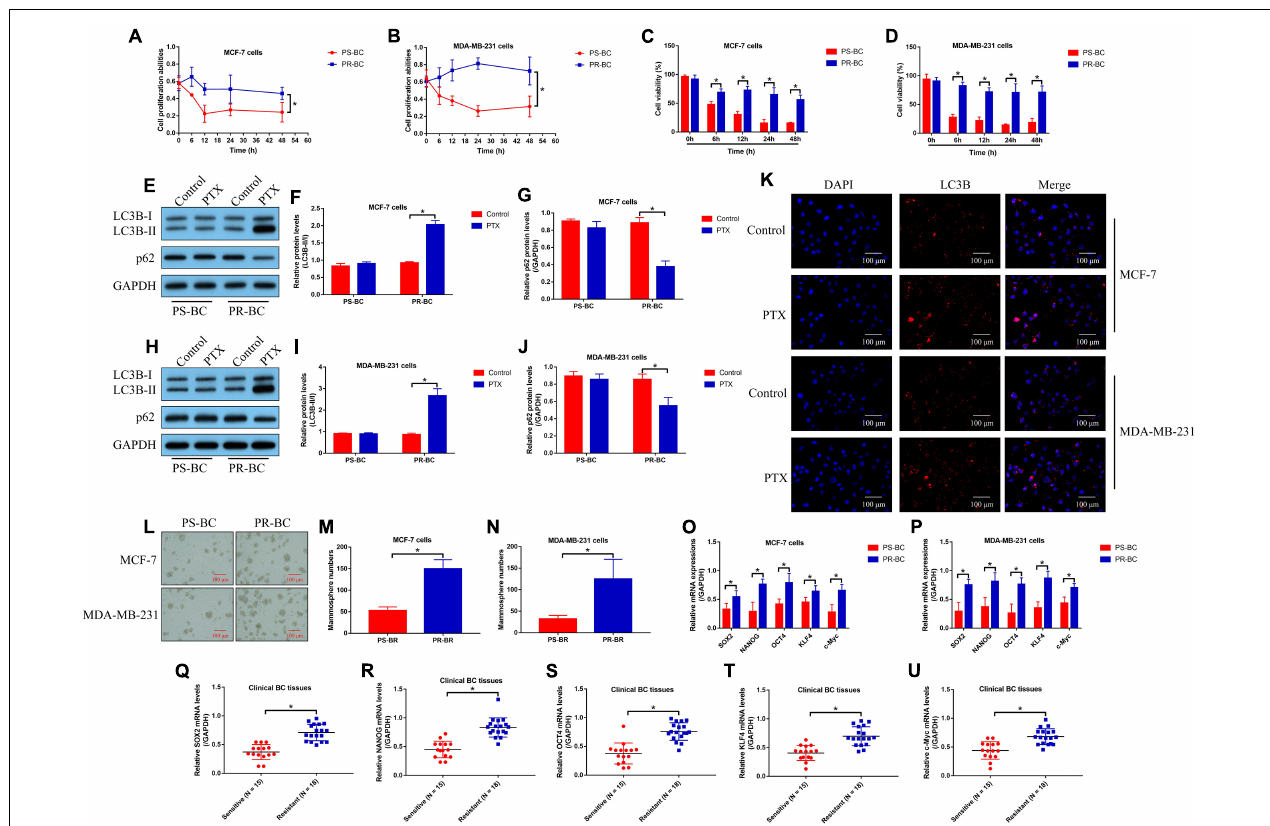
FIGURE 1 | Cell autophagy and stemness were closely relevant to PTX resistance in BC. (A,B) Cell proliferation and (C,D) viability were, respectively, determined by MTT assay and trypan blue staining assay. (E–J) The autophagy-associated proteins were quantified by performing Western blot analysis. (K) The expression levels and localization of LC3B protein in BC cells were determined by immunofluorescent staining assay. (L–N) Spheroid formation assay was used to examine spheroid formation abilities in BC cells. The mRNA levels of SOX2, NANOG, OCT4, KLF4, and c-Myc in (O,P) BC cells and (Q–U) clinical tissues were analyzed by performing real-time qPCR. Single experiment had three repetitions, and * p < 0.05 was regarded as statistical